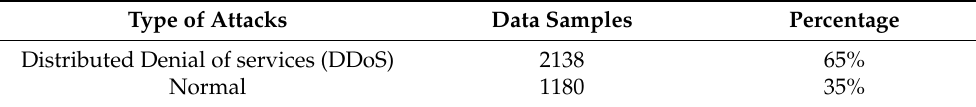
Table 3. Data sample